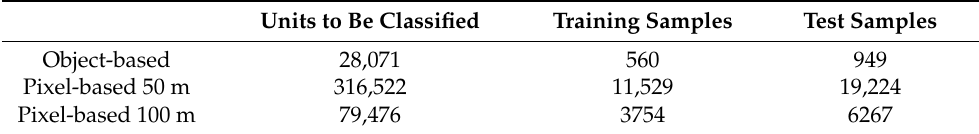
Table 8. Training and test samples of each scheme. The values in the table are the number of